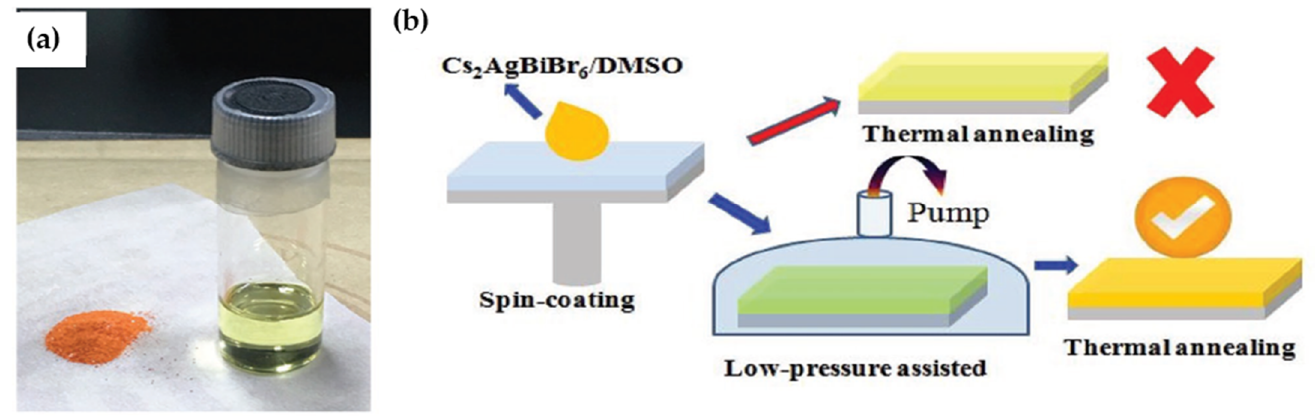
Figure 10. ( a ) images of Cs 2 AgBiBr 6 powder and Cs 2 AgBiBr 6 solution in DMSO and; ( b ) the film fabrication process diagram. Reproduced with permission from [78] . Copyright 2018, Wiley-VCH.